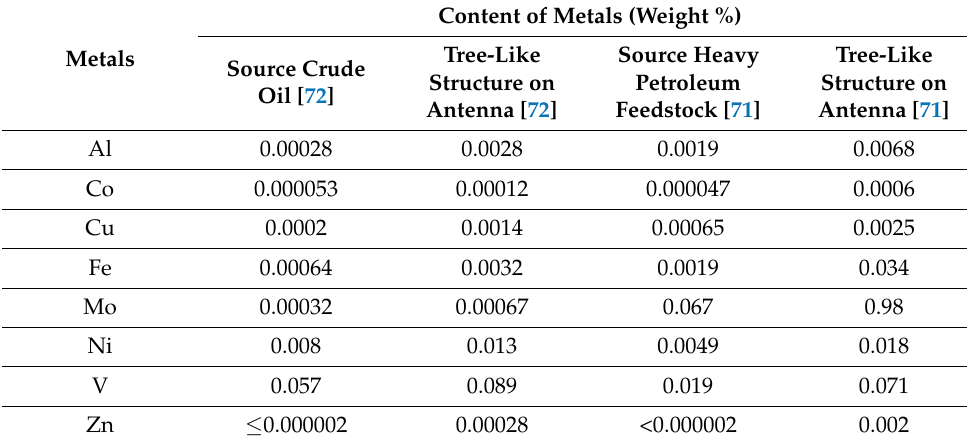
Table 3. Illustration of enrichment of products of microwave discharge in crude oil and liquid residues of heavy petroleum feedstock in valuable